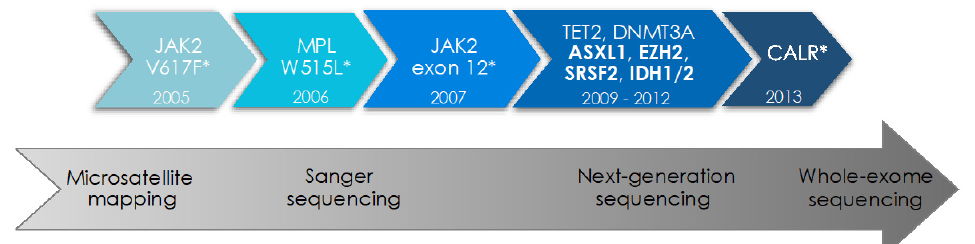
Figure 1. Identification of driver mutations and additional somatic mutations in myeloproliferative neoplasms by modern sequencing technologies. The advent of modern sequencing technologies over the last two decades has led to the characterization of the genetic landscape in myeloproliferative neoplasms (MPN), including driver mutations (*) in JAK2, MPL, and CALR genes as well as concomitant somatic mutations in cancer genes frequently mutated in myeloid malignancies. Mutations in the genes highlighted in bold are considered of “high molecular risk” (HMR) given their adverse prognostic impact. The year of discovery of specific mutations is indicated as well as the development of sequencing methodologies over time.